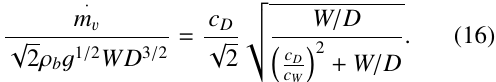
Formulas (15) (dashed curve) and (16) (symbols) are plotted in Fig. 2 where the values c D = 0 . 51 and c W = 0 . 68, as determined by Zhou et al [9] were